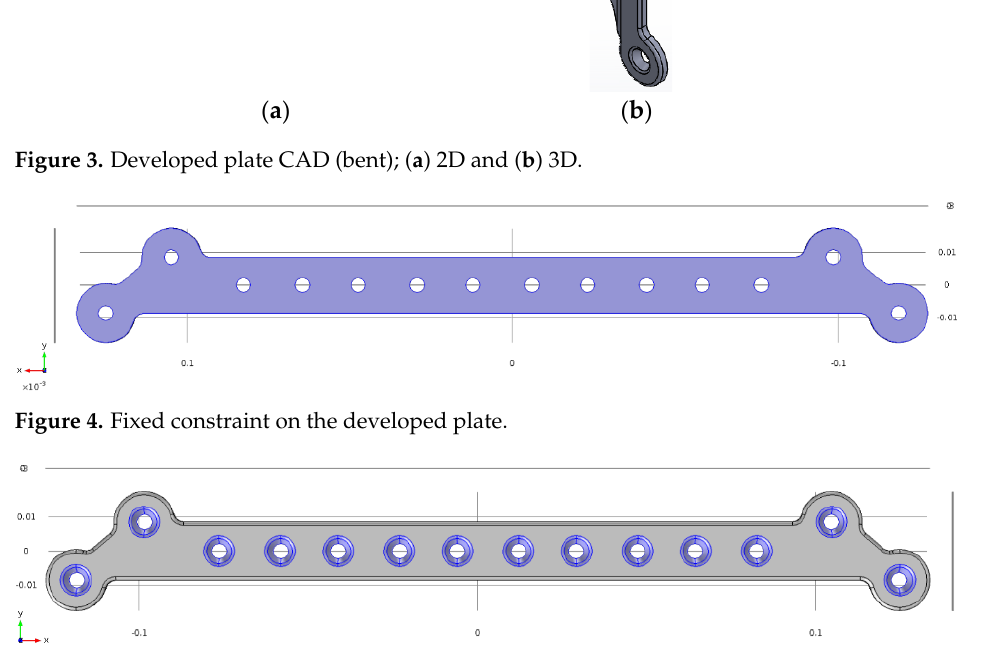
Figure 5. Boundary load on screw holes of the developed plate.